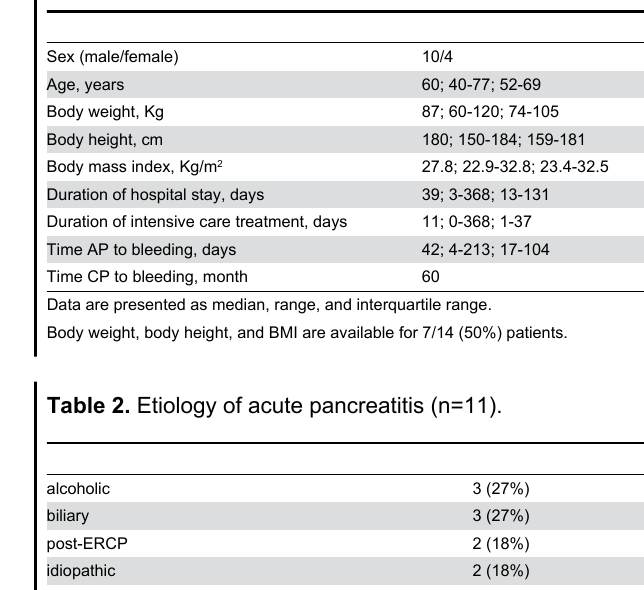
Table 1. Patients’ characteristics (n=14).